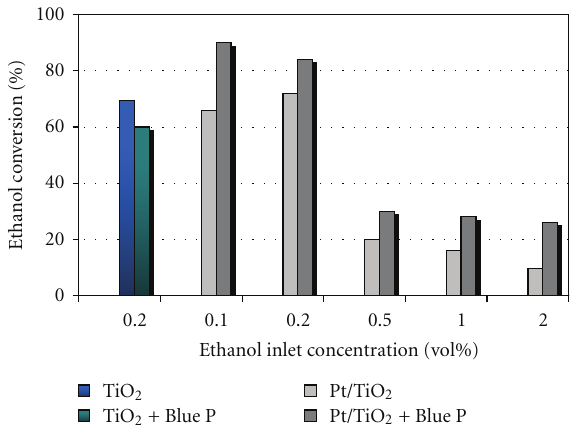
Figure 9: Ethanol conversion on Pt/TiO 2 photocatalyst as a func- tion of ethanol inlet concentration.